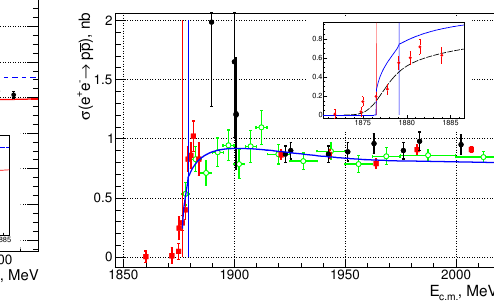
Figure 5. The e + e − → p ¯ p Born cross section measured with CMD-3 (dots [15] and squares) and BaBar (open circles). The solid curve shows the result of the prediction from Refs. [11–13]. The inset shows the expanded view of the visi- ble cross section from CMD-3 with the theoret- ical prediction for the Born (solid line), and for the visible cross section (dashed line) with the experimental e ff ects. The vertical lines show the p ¯ p and n ¯ n